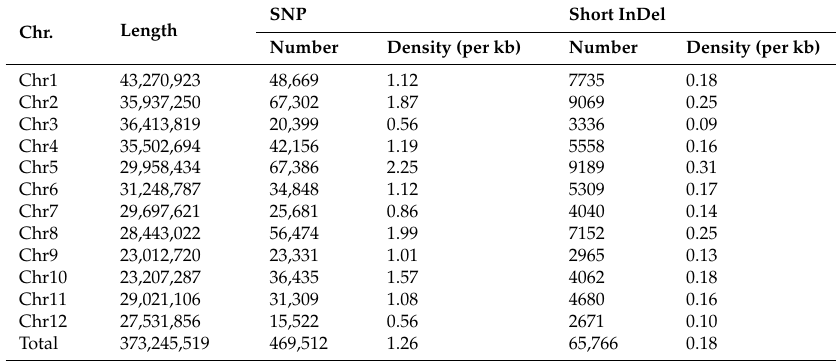
Table 1. Chromosome-wise distribution of the identified single-nucleotide polymorphisms (SNPs) and short